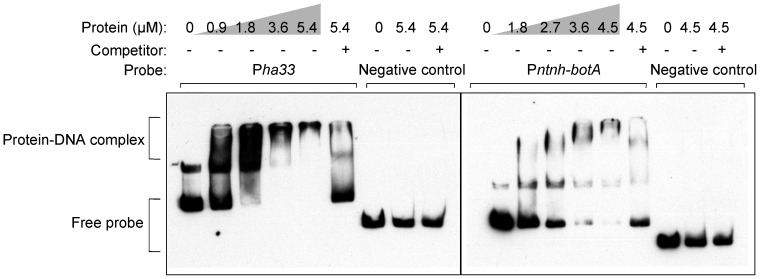
CBO0786 binds to botulinum neurotoxin promoters in vitro.EMSA showing CBO0786 binding to Pha33 probe (left panel) and Pntnh-botA probe (right panel). Specificity was confirmed using 200-fold molar excess of non-labeled competitor DNA and a random gene fragment as negative control.